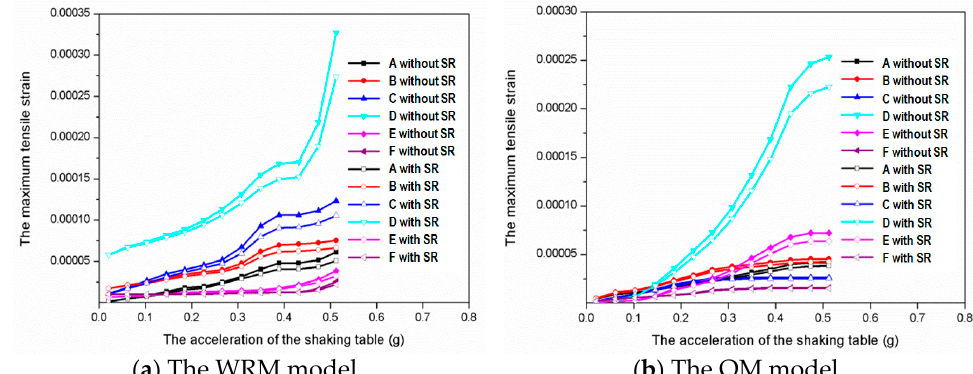
Figure 6. The maximum tensile strain of the model.